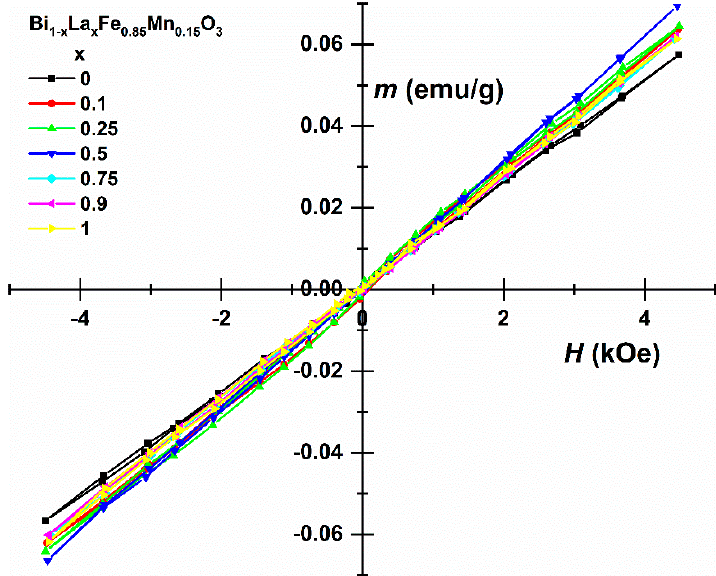
Figure 6. Hysteresis loops of Bi 1-x La x Fe 0.85 Mn 0.15 O 3 samples.